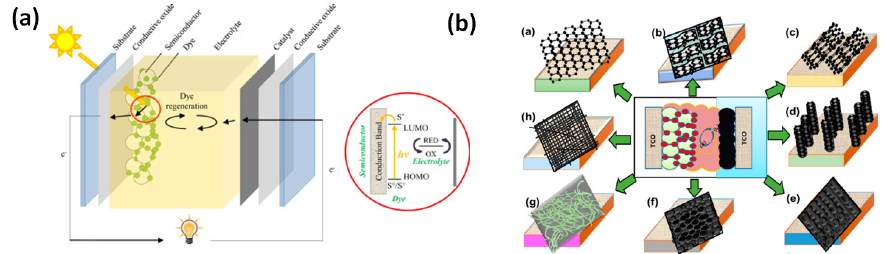
Figure 1. ( a ) A sketch of the DSSC structure and operational mechanism [6]. ( b ) Schematic diagrams showing different types of carbon materials used as CEs in DSSCs (in the subfigure (a) graphene, (b) graphite, (c) randomly oriented carbon nanotubes, (d) one-directional carbon nanotubes, (e) carbon black, (f) activated carbon, (g) carbon nanofibers, and (h) hollow active carbon nanofibers) [7]. (Reproduced from Ref. [6], 10.1016/j.rser.2014.07.079, under the terms of the CC